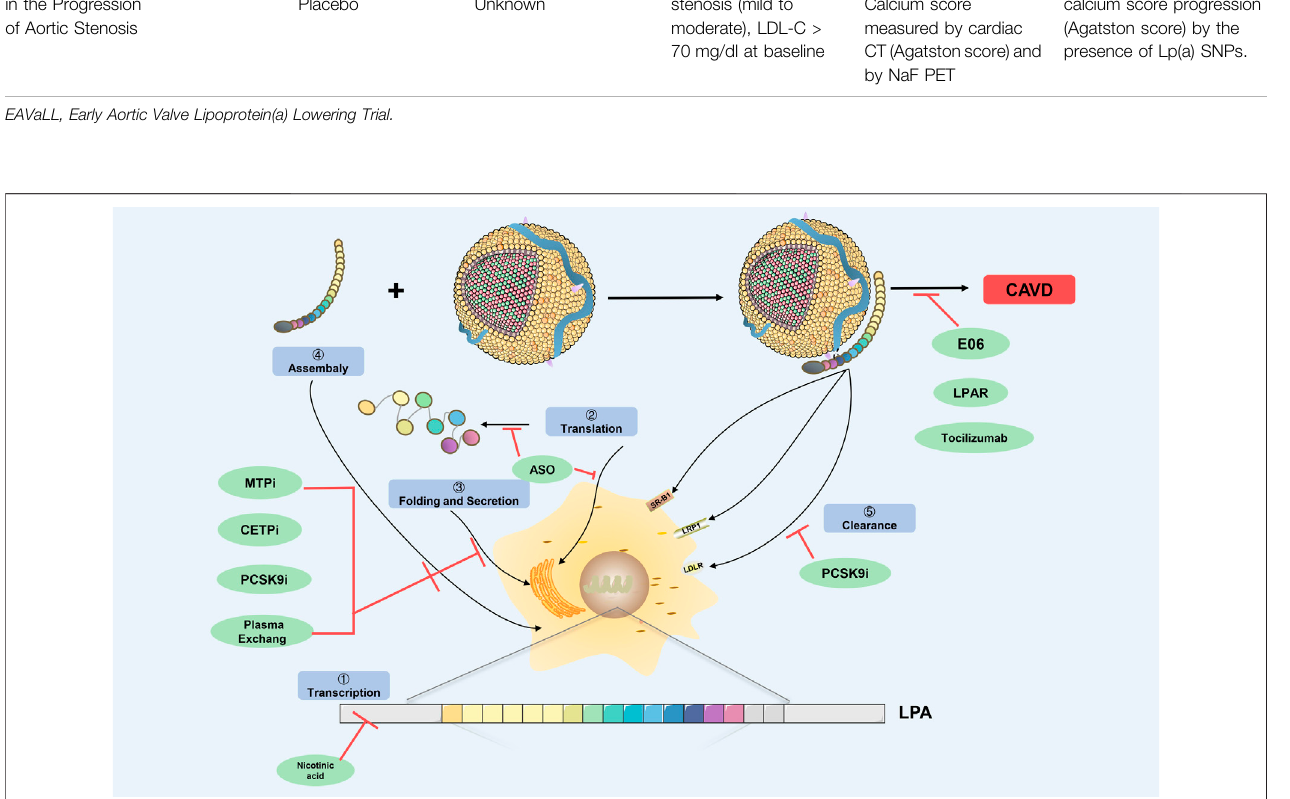
Mean change in Lp(a) levels between treatment arms, Change in peak velocity (in m/s); Change in mean gradient (in mmHg); Change in AV area (in cm2) Ef fi cacy of inhibition in calcium score progression (Agatston score) by the presence of Lp(a) SNPs.